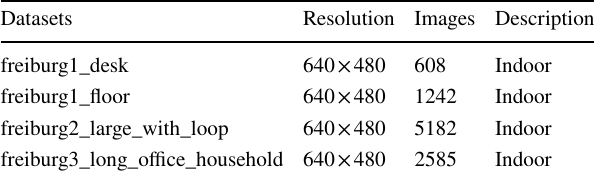
Table 2 The pictures of TUM datasets Datasets Resolution Images Description